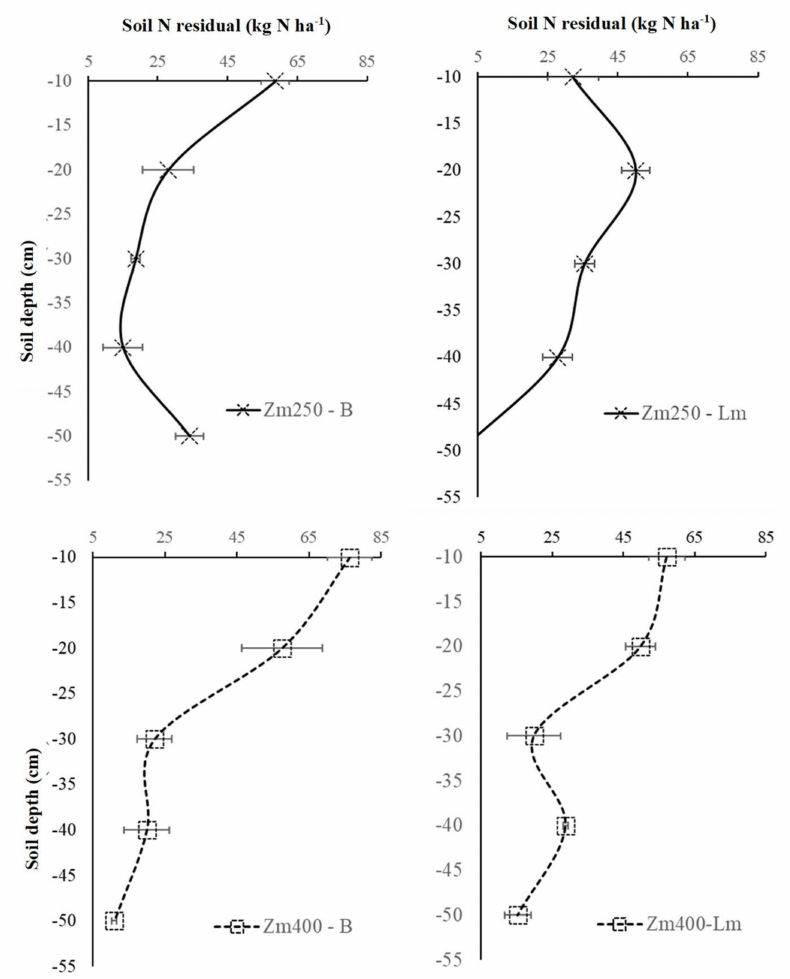
Figure 4. Soil residual N in the treatments at different soil depths, including standard deviation error